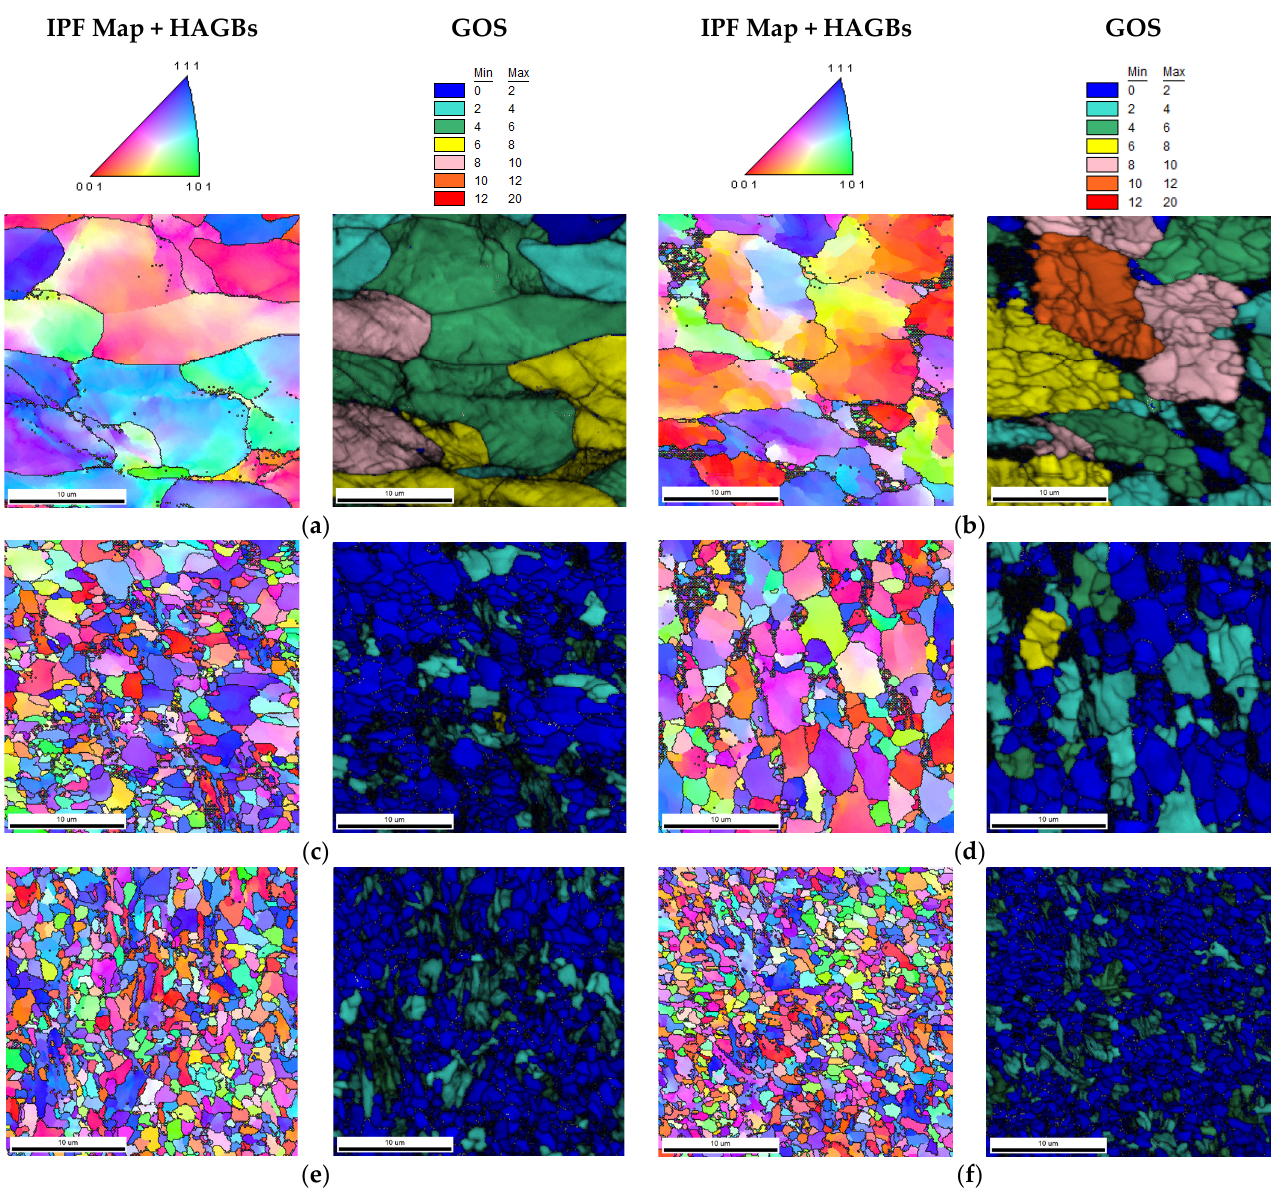
Figure 10. Inverse pole figure (IPF) maps with HAGBs, and GOS parameter images of measurement areas of a high-speed friction welded joint made of S235JR steel; ( a ) Base material ; ( b ) ‘400 ′ ; ( c ) ‘300 ′ ; ( d ) ‘200 ′ ; ( e ) ‘100 ′ ; ( f ) ‘0 ′ –Friction weld .